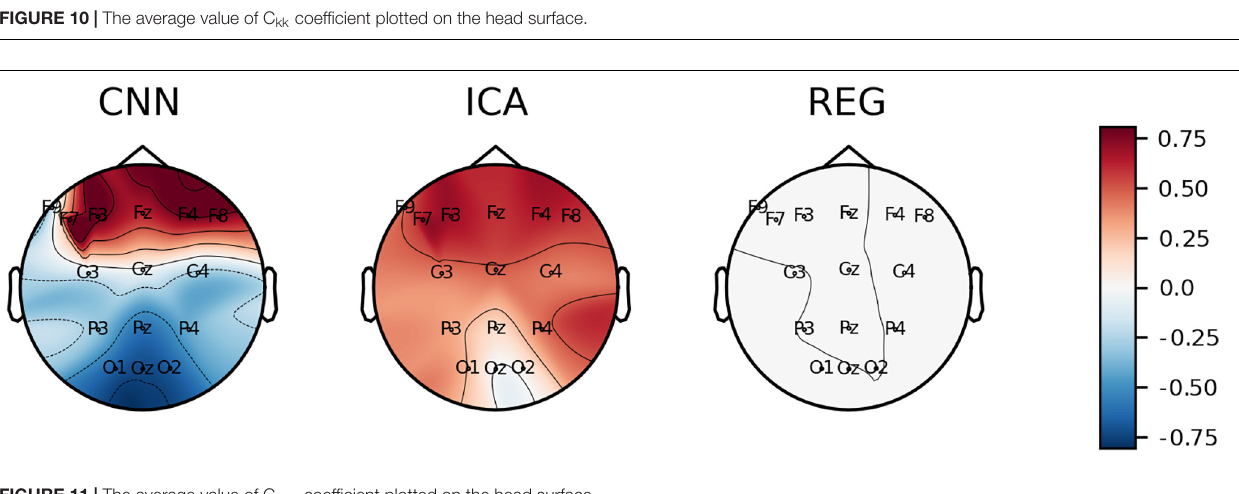
FIGURE 11 | The average value of C Fp1 coefficient plotted on the head surface.